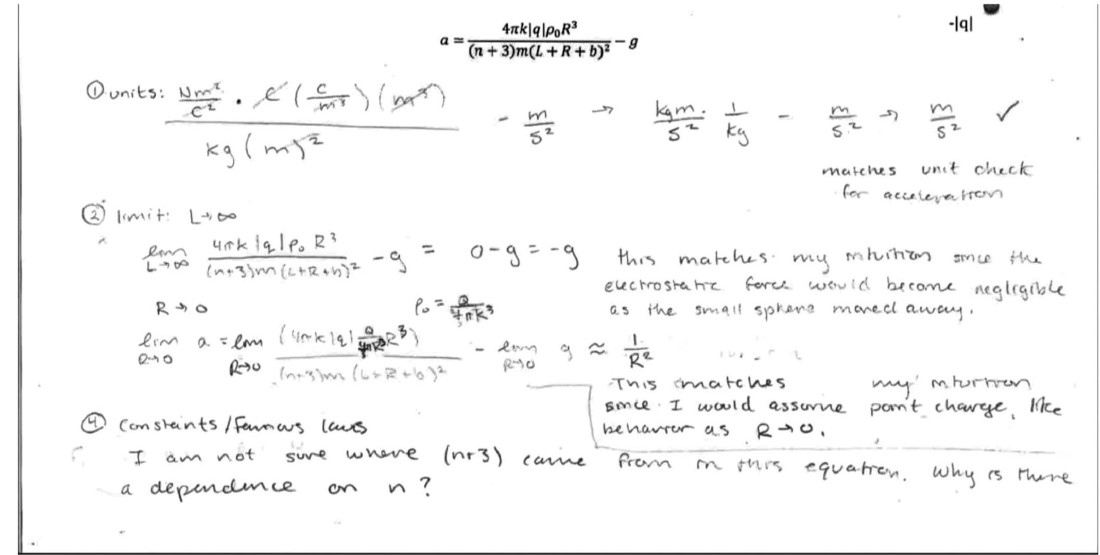
FIG. 9. Student recognizes 1 =R 2 dependence is to be expected and overlooks other R